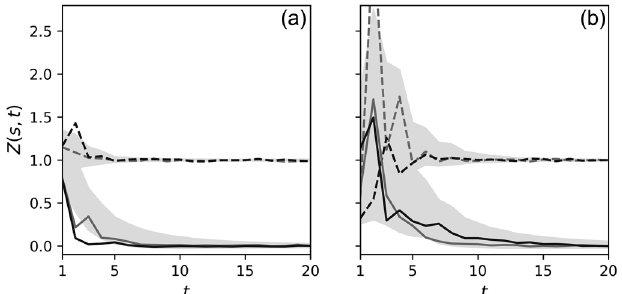
FIG. 18. Approach toward a global orbit pairing in individual circuit realizations for (a) L ¼ 4 and (b) L ¼ 8 sites. The dashed and solid lines show Z ð 0 ; t Þ and Z ð 1 ; t Þ , respectively, for two randomly selected realizations (one in gray, the other in black). ¯ Z ð s; t Þ The shaded areas are centered on and have vertical width equal to twice the ensemble standard